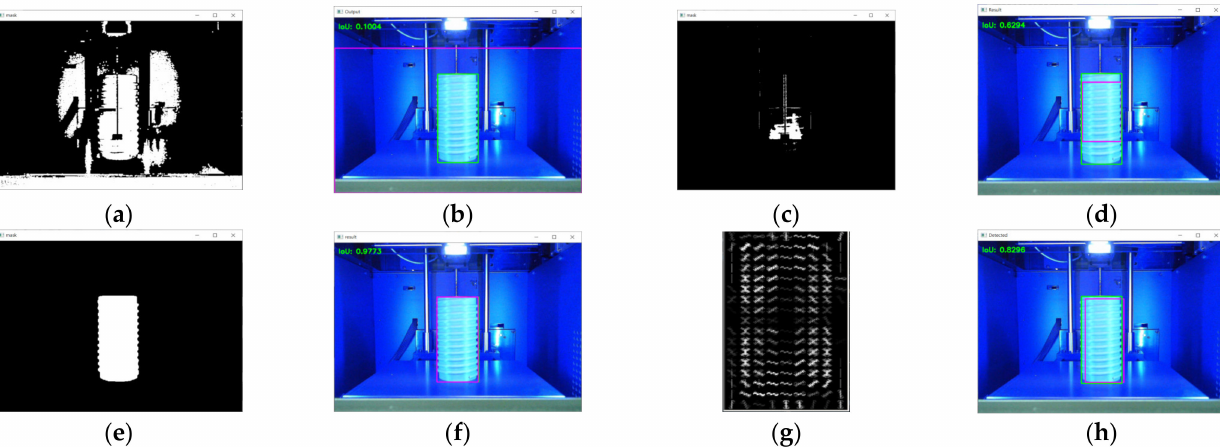
Figure 8. Test 1 product result of background subtraction by the Otsu and GMM algorithms: ( a ) foreground mask of the background subtraction by the Otsu algorithm; ( b ) test result of the background subtraction by the Otsu algorithm; ( c ) foreground mask of the background subtraction by the GMM algorithm; ( d ) test result of the background subtraction by the GMM algorithm; ( e ) foreground mask of the GrabCut algorithm; ( f ) test result of the GrabCut algorithm; ( g ) gradient vector of the HOG algorithm; ( h ) test result of the HOG algorithm.